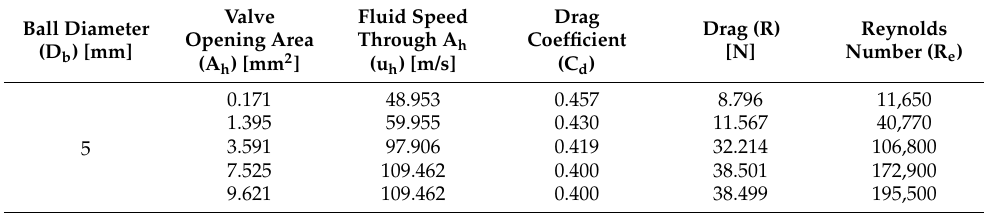
Table 6. Drag of the ball 50 ◦